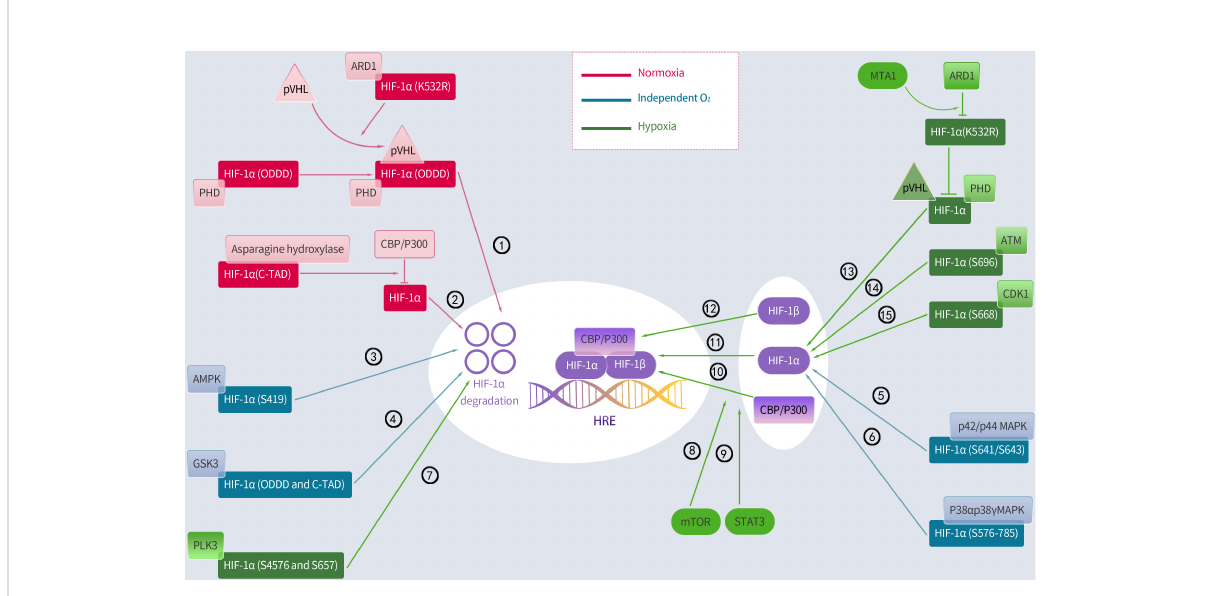
FIGURE 2 Regulation of HIF-1 a by hydroxylation, phosphorylation and acetylation. Activated regulatory pathways under normoxia: ①② ; Activation of the following pathway is less associated with oxygen: ③④⑤⑥ ;Activated regulatory pathways under hypoxia: ⑦⑧⑨ ⑩⑪⑫⑬⑭⑮ . PHD, prolyl hydroxylase; pVHL, Von Hippel-Lindau protein; ARD1, arrest defective-1; CBP/P300, cAMP response element binding protein (CREB)-binding protein and P300; ODDD, oxygen-dependent degradation domain; AMPK, adenosine 5 ’ -monophosphate (AMP)-activated protein kinase; GSK3, glycogen synthase kinase-3; PLK3, polo-like kinase-3; MTA1, metastasis-associated protein 1; ATM, ataxia and telangiectasia mutated; p42/p44 MAPK, mitogen-activated protein kinase; CDK1, cyclin-dependent kinase-1; mTOR, mammalian target of rapamycin; STAT3, signal transducer and activator of transcription